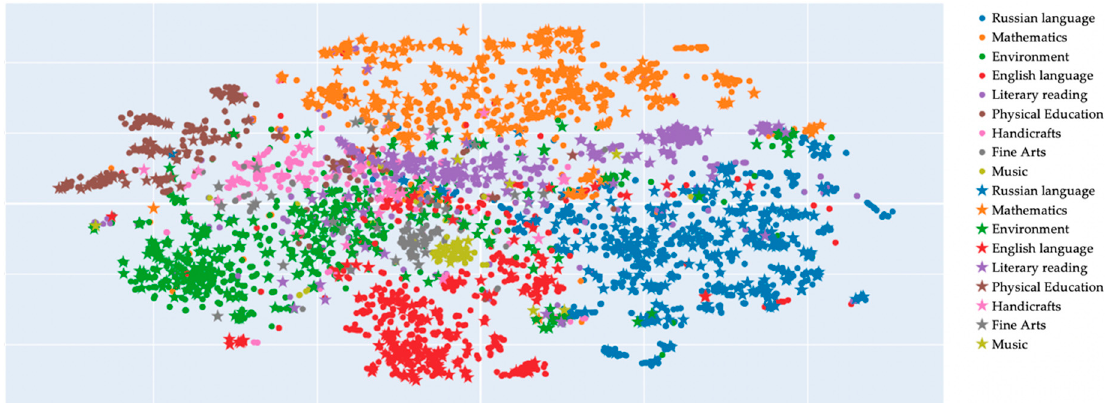
Figure 1. Visualization of lesson scripts in the MES by subject topic proximity. Primary general education.